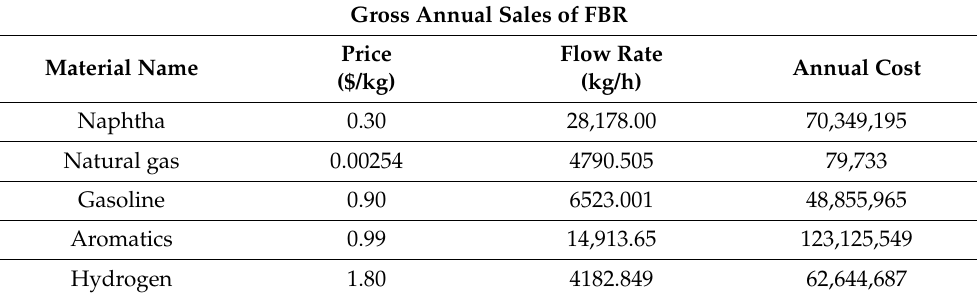
Table 7. Gross annual sales of FBR.